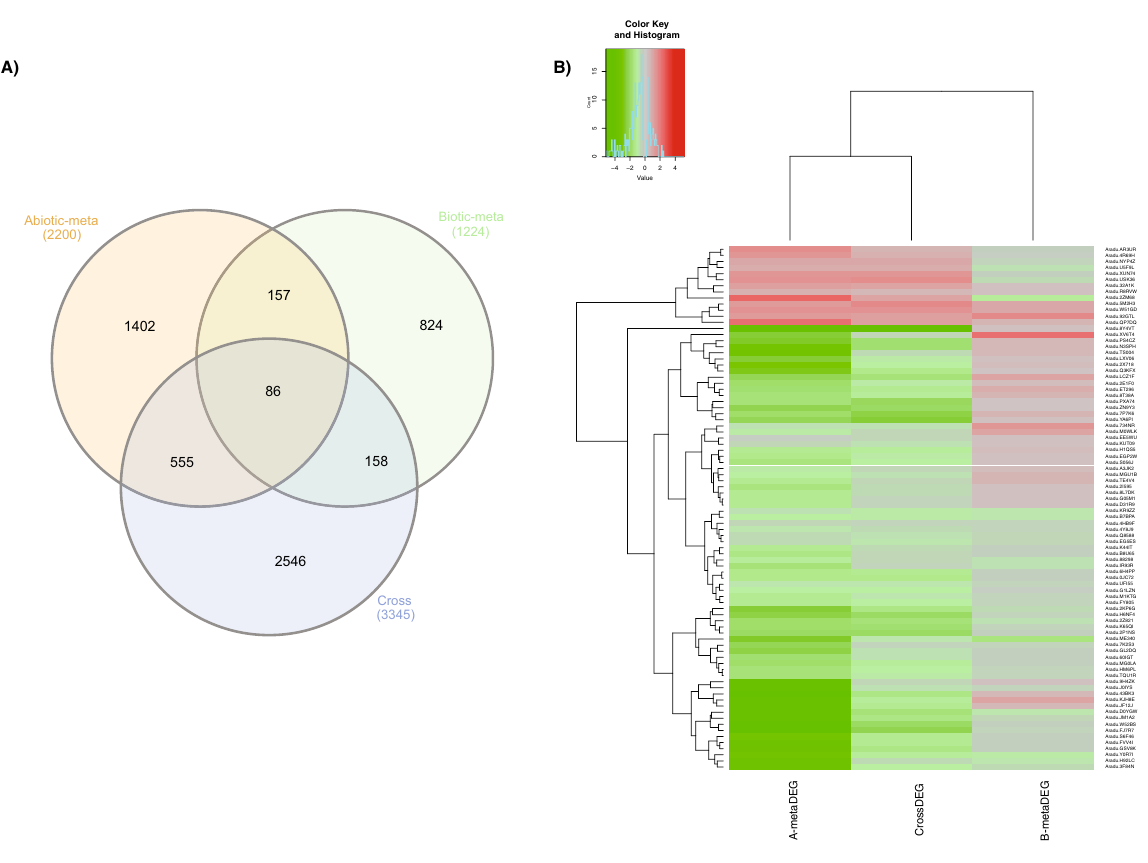
Figure 2. Comparison between predicted genes from (A- and B-metaDEGs) and observed de facto cross-stress DEGs (crossDEGs). (A) Venn diagram of A-metaDEGs, B-metaDEGs and crossDEGs; (B) expression profile of the 86 common DEGs in response to de facto cross-stress (crossDEGs) and to all abiotic (A-metaDEGs) and biotic (B-metaDEGs) treatments using gplots. The color key represents the values of log2FC.